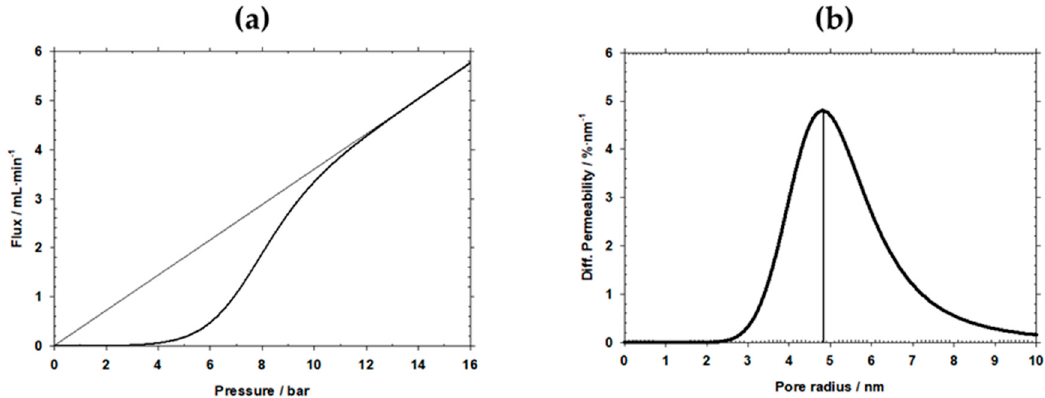
Figure 5. Flux versus pressure fort the HFM-183 membrane (a) and the corresponding permeability pore size distribution (b) .